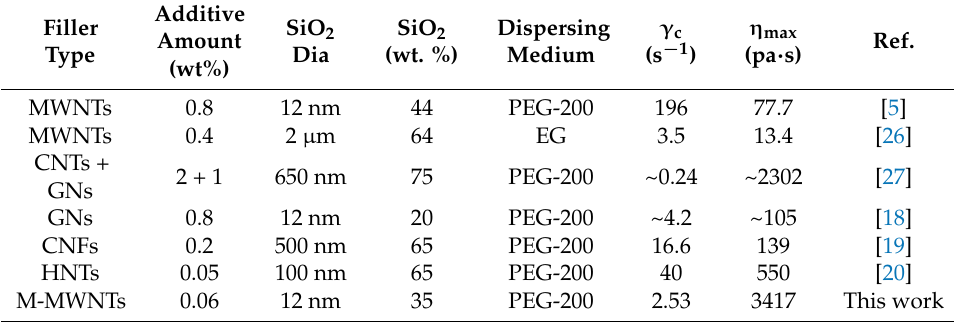
Table 1. Rheological properties comparison of nanofillers added in